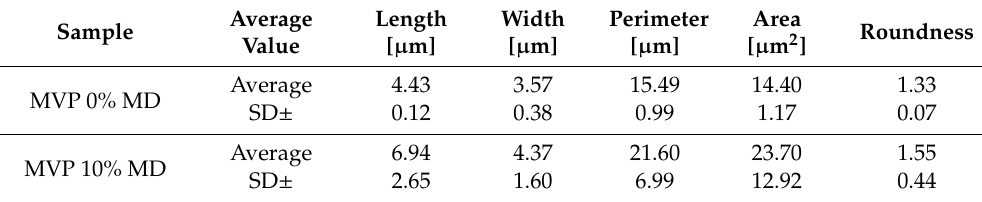
Table 2. Particle size analyses of MVPs obtained by optical